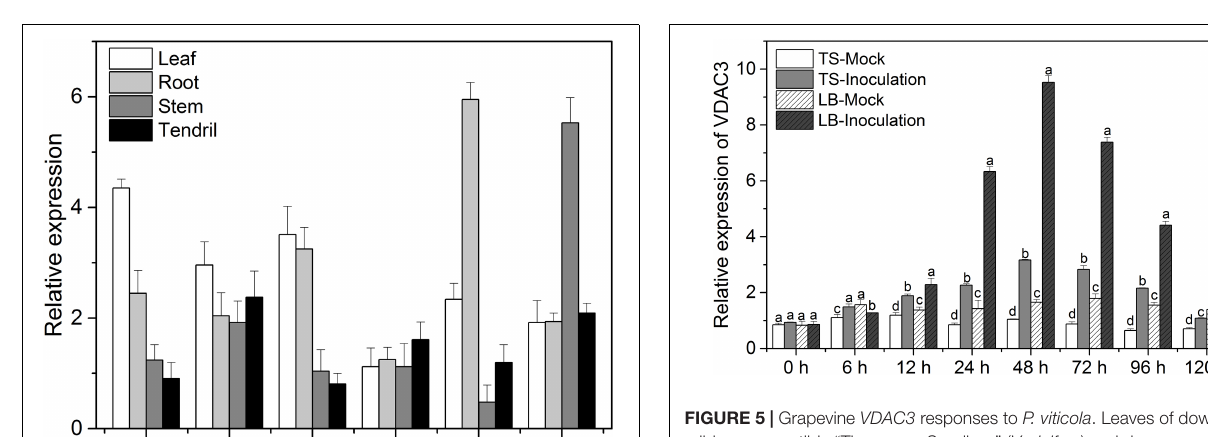
FIGURE 5 | Grapevine VDAC3 responses to P. viticola . Leaves of downy mildew-susceptible “Thompson Seedless” ( V. vinifera ) and downy mildew-resistant “Liuba-8” ( V. piasezkii ) were inoculated either with P . viticola or water suspension (mock). TS Mock, “Thompson Seedless” sprayed with water suspension; TS Inoculation, “Thompson Seedless” sprayed with P . viticola ; LB Mock, “Liuba-8” sprayed with water suspension; LB Inoculation, “Liuba-8” sprayed with P . viticola . Samples were harvested for qRT-PCR analysis after 0, 6, 12, 24, 48, 72, 96, and 120 h treatment. Error bars indicate the SE ( n = 3) from three independent biological replicates. Different letters (a–d) in the same time represent significant difference at P < 0.05